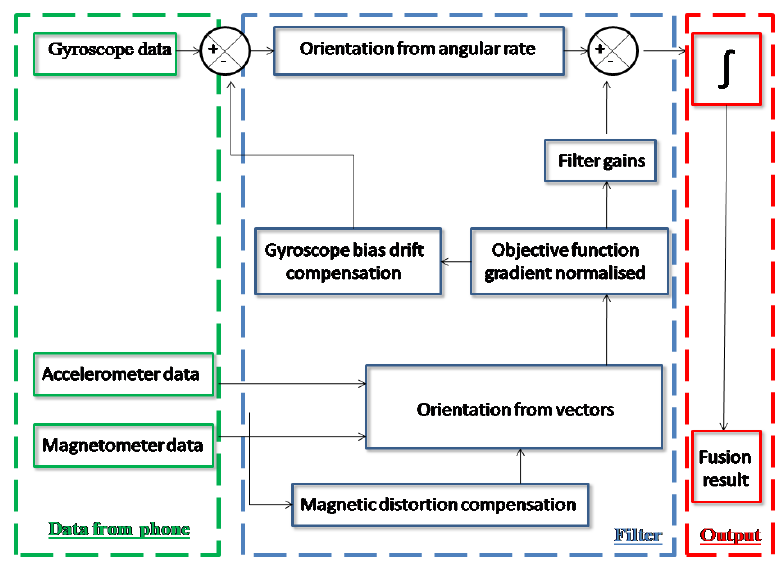
Figure 2. Block diagram representation of a common orientation filter using accelerometer, magnetometer and gyroscope